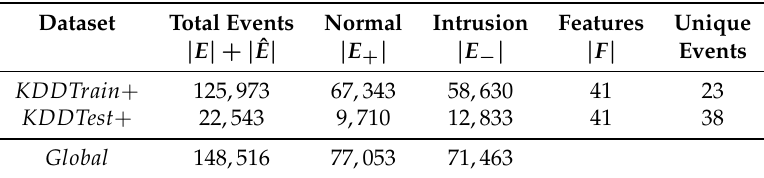
Table 6. Numerical relevance of the original dataset events.